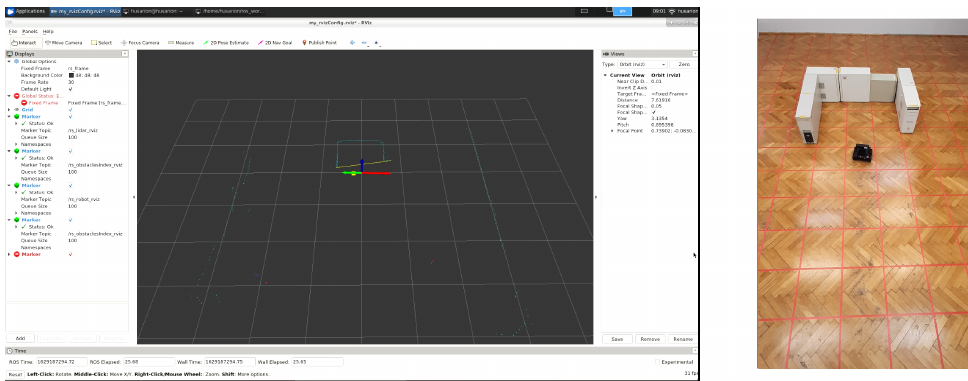
Figure 12. Real photo and RViz visualization at the same timestamp as the image number III in Figure 11.